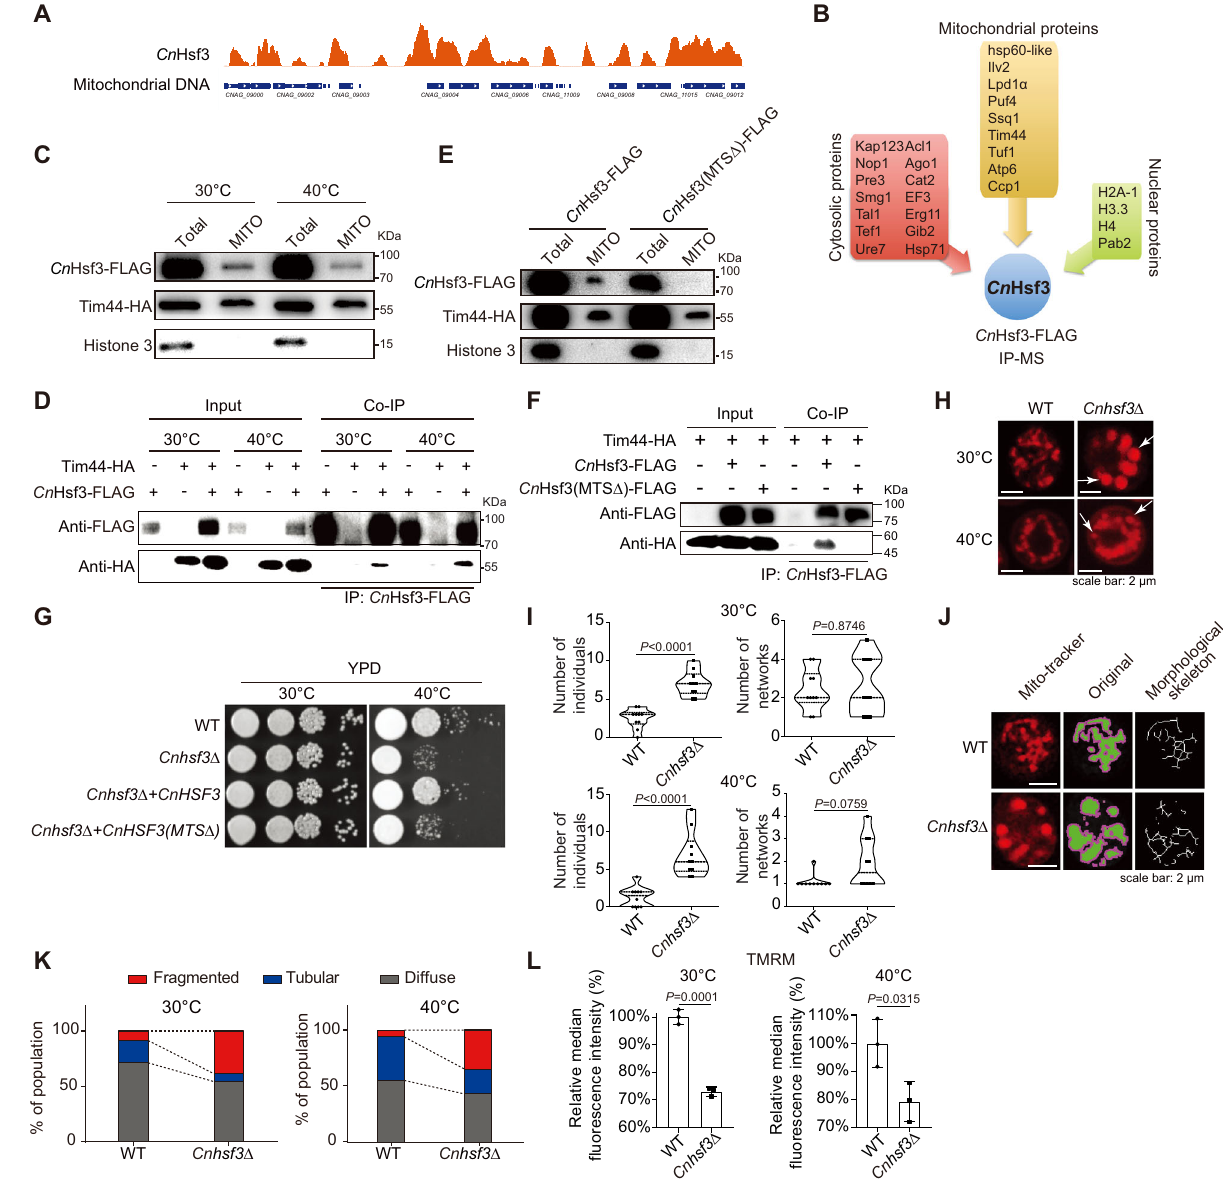
Fig. 4 | C n Hsf3 is a mitochondrial targeting transcription factor. A Scheme of Cn Hsf3-FLAG binding on mitochondrial DNA. B Cn Hsf3-FLAG protein isolated by co-IPfollowedbymassspectrometry. Cn Hsf3-FLAGinteractingproteinsareshown. C Mitochondria isolation and immunoblots. Mitochondria isolated from cells grown at 30 or 40°C were analyzed using immunoblotting. Data were obtained ments and representative images are shown. I Quantifying the mitochondrial structures. The ImageJ MiNA toolset was used to count individual and